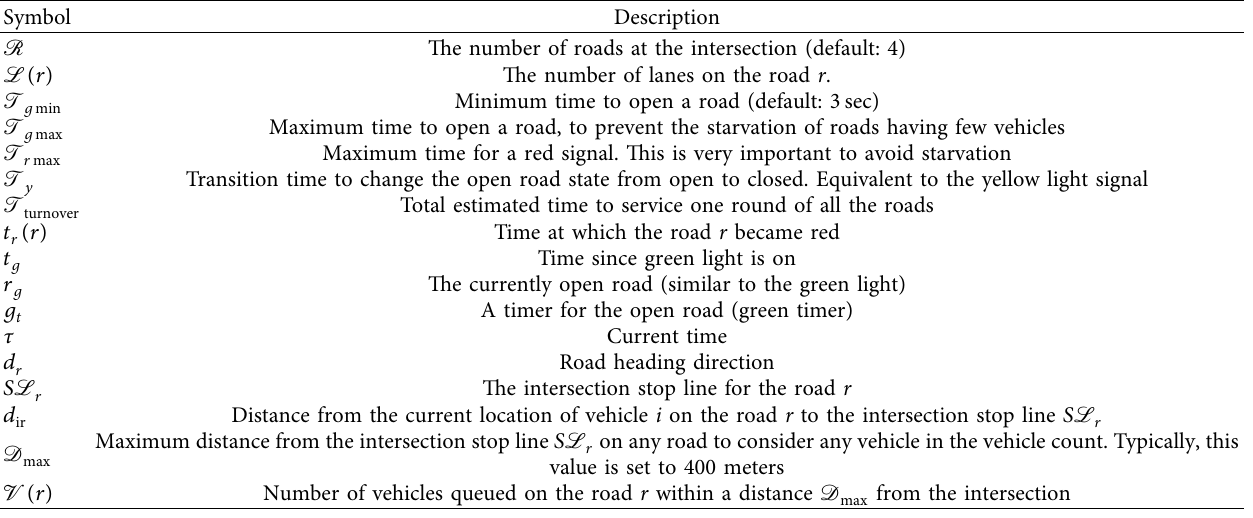
The intersection stop line for the road r